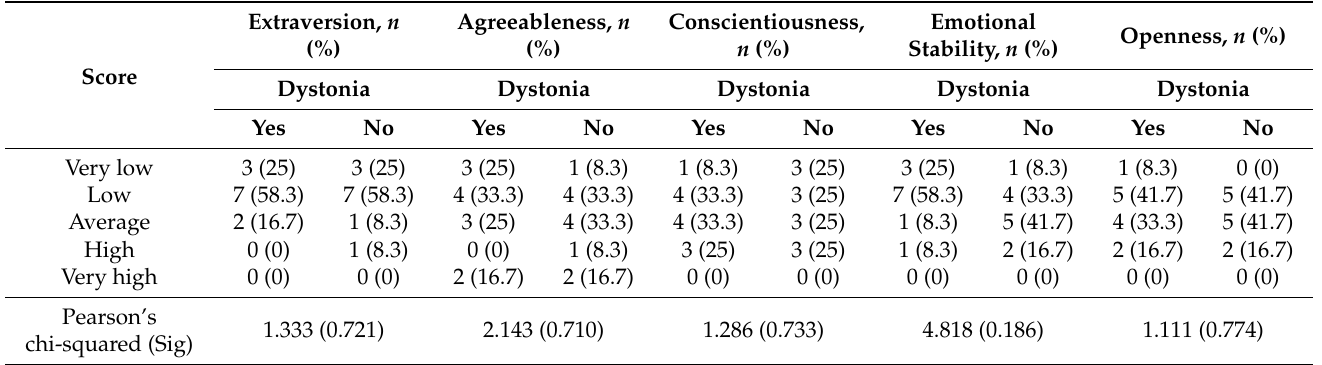
Table 2. Description of the sample by dimensions and Chi-squared comparison.